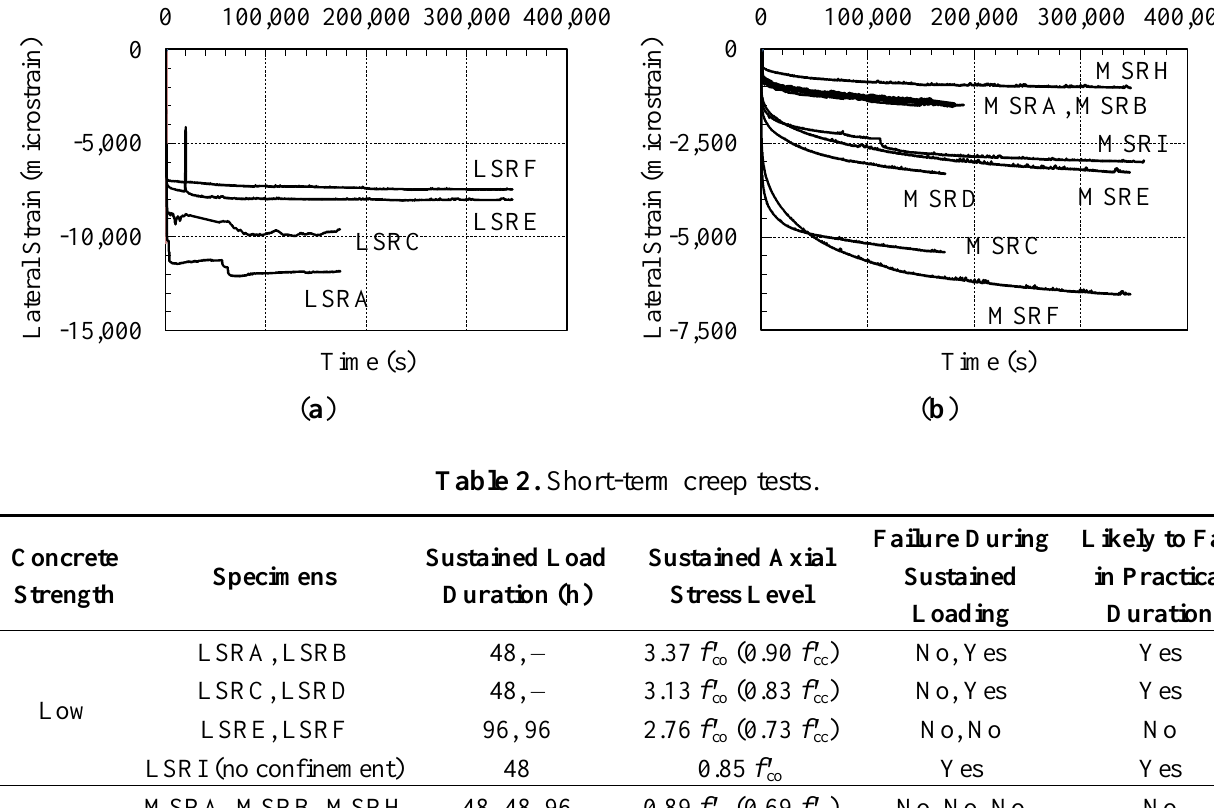
Figure 9. The variation of lateral strains with time. ( a ) Low-strength concrete. ( b ) Medium-strength concrete.